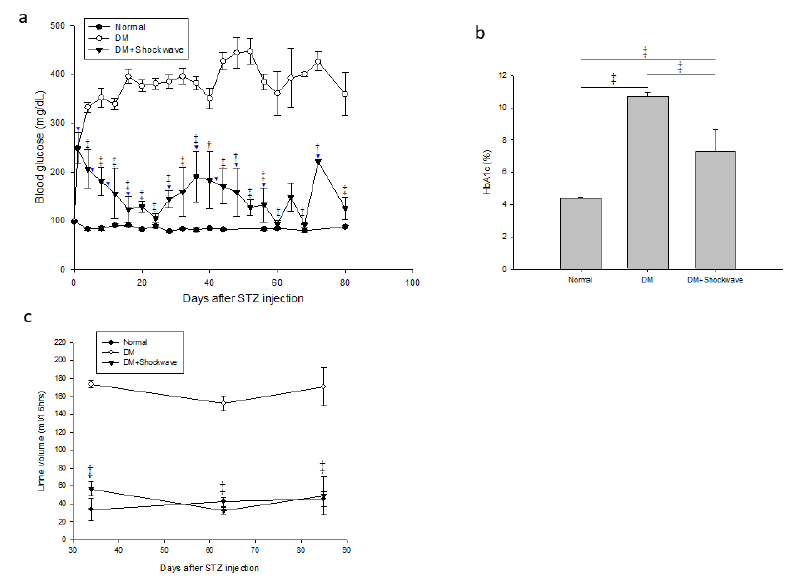
Figure 1. Low-energy SW significantly reduced blood glucose, hemoglobin A1c and urine volume in DM. ( a ) Blood glucose (mg/dl). † p <0.01, ‡ p <0.001 versus DM. ▼ Low-energy SW; ( b ) Blood HbA1c. ‡ p <0.001; ( c ) Urine volume (ml/16 h). ‡ p <0.001 versus DM. Data are represented as mean ± SEM ( n = 12). Normal control (Normal) group, streptozotocin induced diabetes (DM) group and DM with low- energy SW (DM + Shockwave) group, streptozotocin (STZ). Int. J. Mol. Sci. 2019 , 20 , x FOR PEER REVIEW